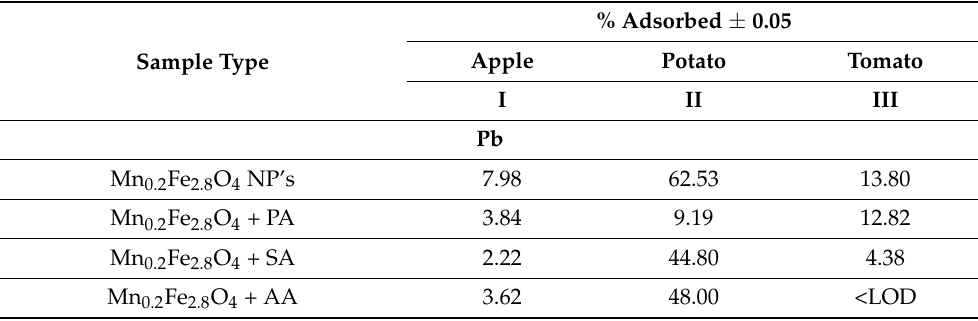
Table 1. Percentage identification of elements in respective juices (columns) and selected modifiers (rows) (LOD—detection limit